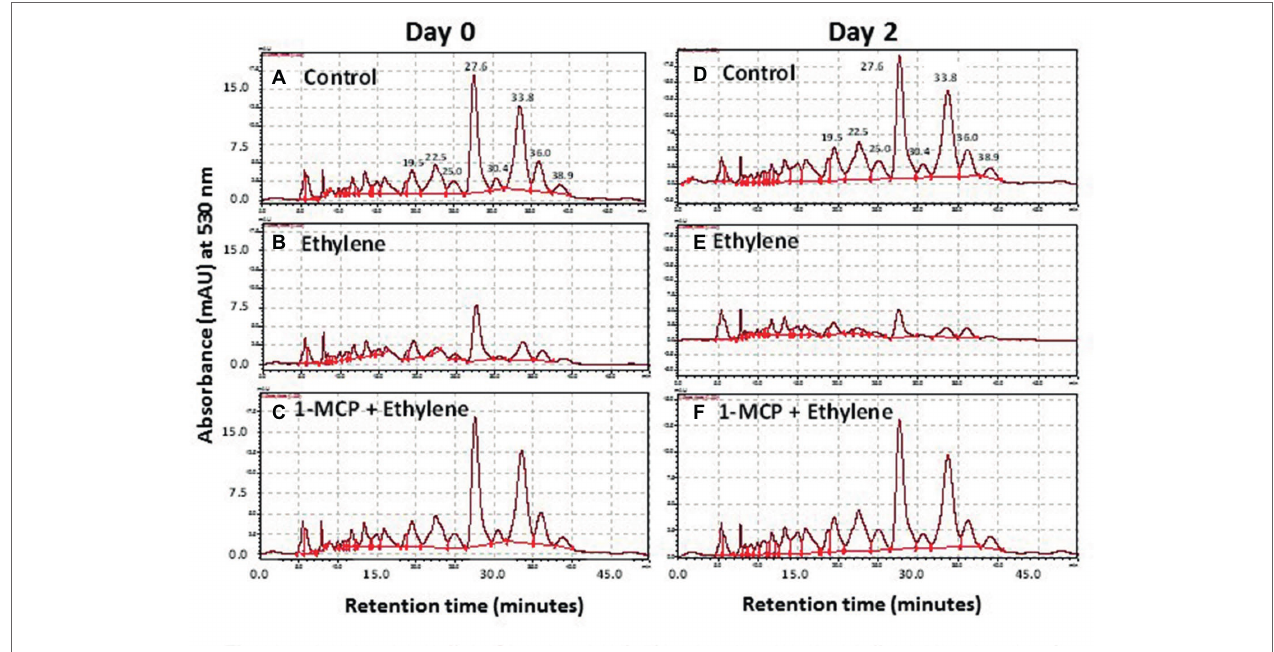
FIGURE 4 | Representative chromatograms of non-hydrolyzed anthocyanins, extracted from Vanda cv. ‘Sansai Blue’ florets, showing changes in the content of the two main anthocyanin peaks in response to ethylene and 1-MCP pre-treatments, immediately (A–C) and 2 days (D–F) after treatments. Anthocyanins were extracted from control (A,D) , ethylene-treated (B,E) or 1-MCP, and ethylene-treated (C,F) florets at the bloom developmental stage (see Figure 1A ). Ethylene and 1-MCP pre-treatments were applied as detailed in Figure 2 .